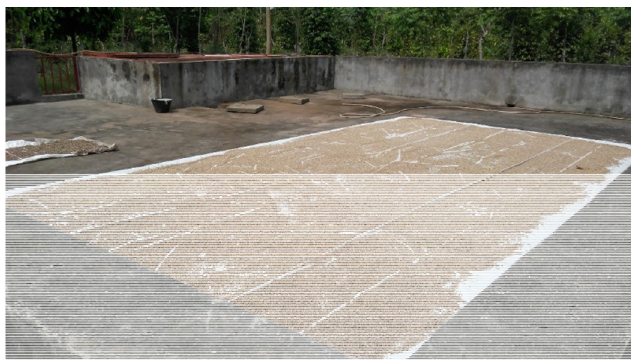
Figure 3. Nematodes facilitate gall diseases and fungi contamination; a defoliated plant after fungi attack (Njombe, Cameroon).